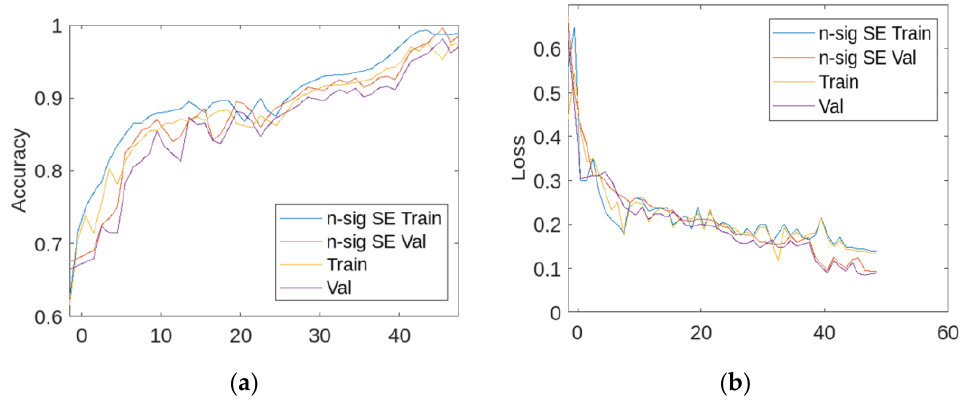
Figure 13. Evolution of the training and validation accuracy ( a ) and loss ( b ) curves of the 3D SE UNet and the n-sigmoid 3D SE UNet.